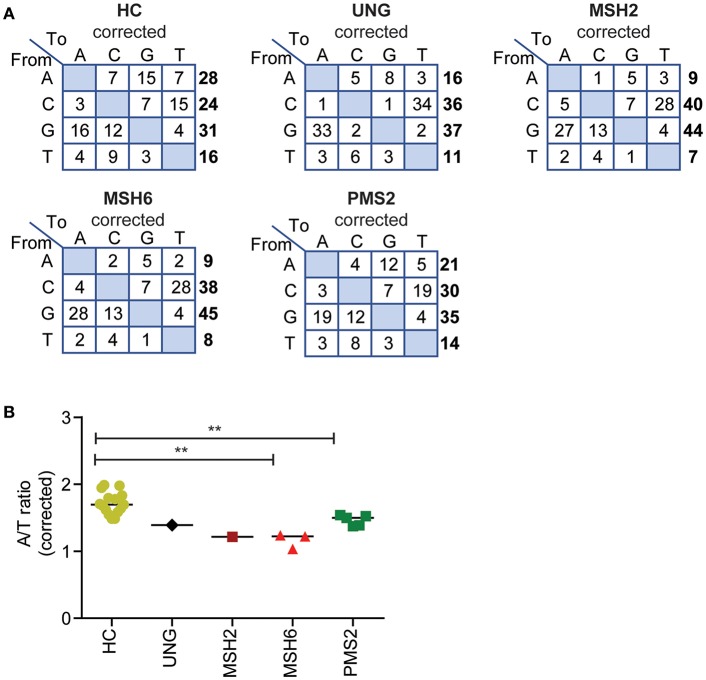
Defects in UNG, MSH2, MSH6, and PMS2 influence the corrected A/T ratio. (A) Transition tables of the percentage of mutations corrected for the A,C,T, and G content of the sequenced transcripts. (B) The corrected A/T ratio in HCs and patients with genetic defects in UNG, MSH2, MSH6, and PMS2. Statistical significance was performed using a Mann–Whitney test and indicated using **P < 0.01.